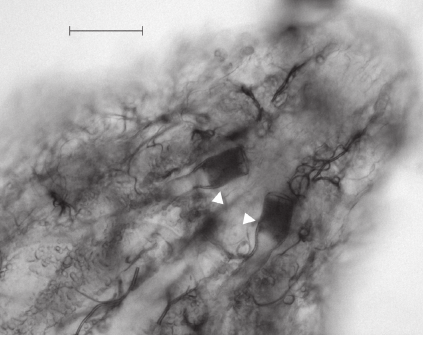
Figure 3: Terminal segments of O. ovis L1 (200x). White arrows indicate tracheal trunks and black bar indicates 50 𝜇 m